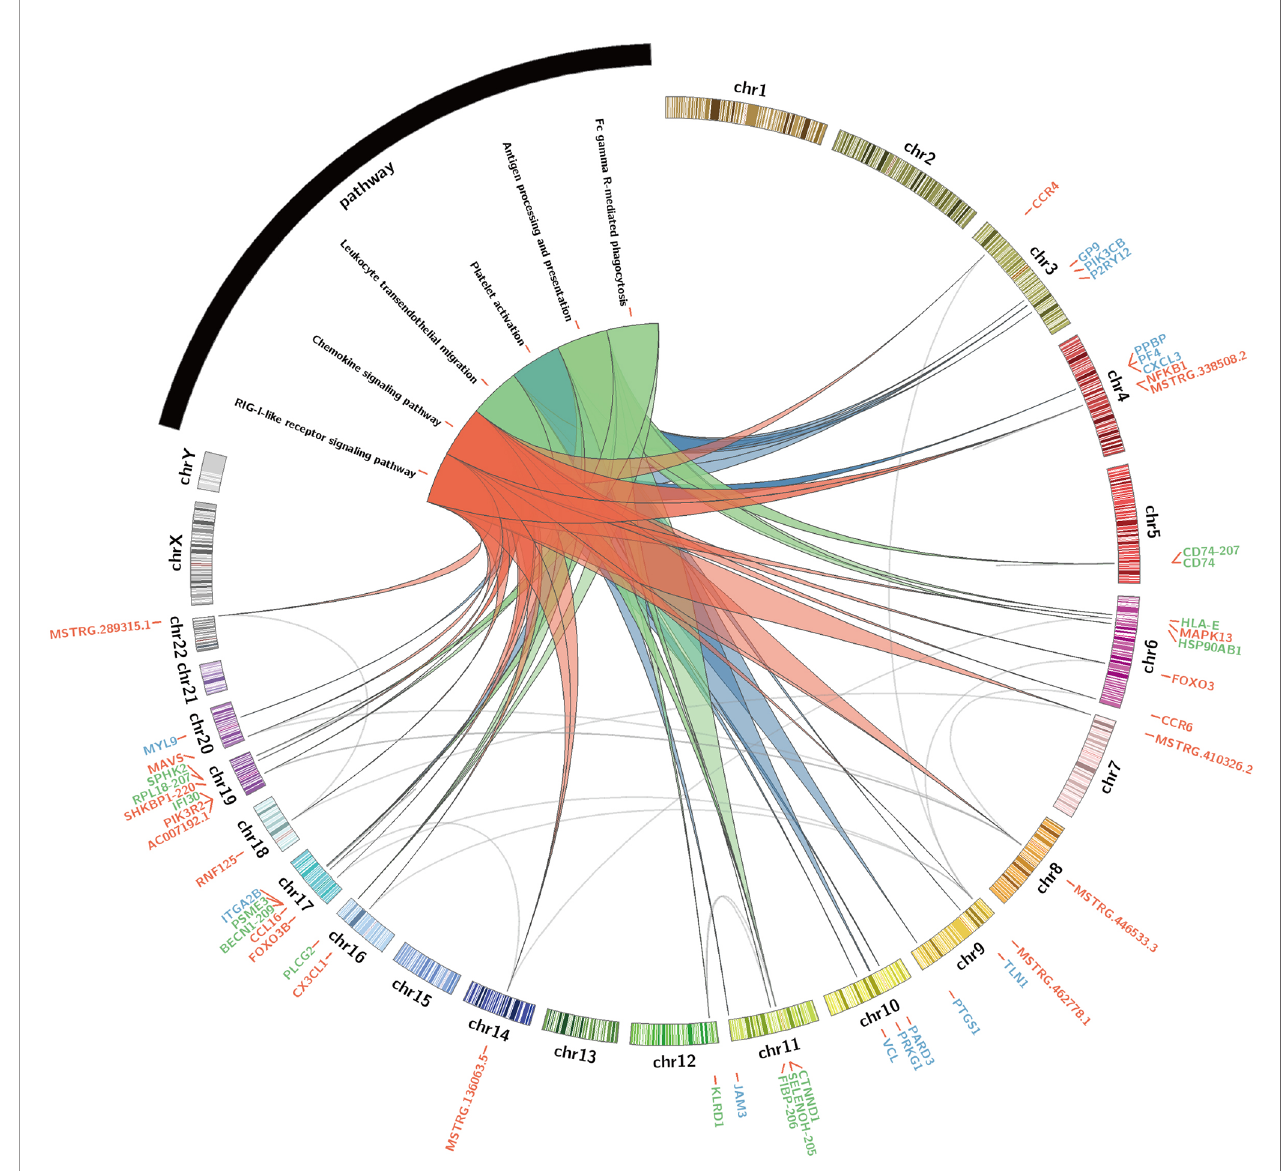
FIGURE 5 | Identi fi cation of immune-related lncRNA-mRNA-pathway network. Circos plot showing the top-ranked lncRNA – mRNA-pathway pairs in heroin AW and PW stages. Red, blue (AW stage) and turquoise (green, PW stage) colors represent the corresponding modules and